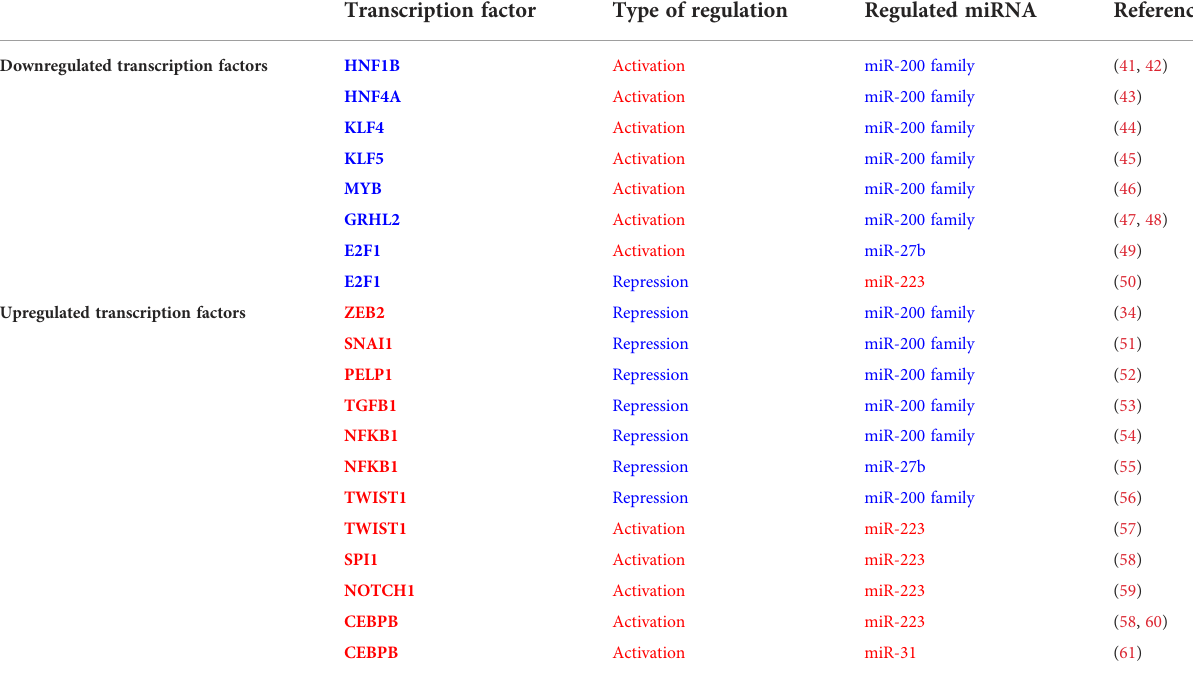
TABLE 3 Expression changes of miRNAs and their regulator transcription factors in the in fl amed colon.